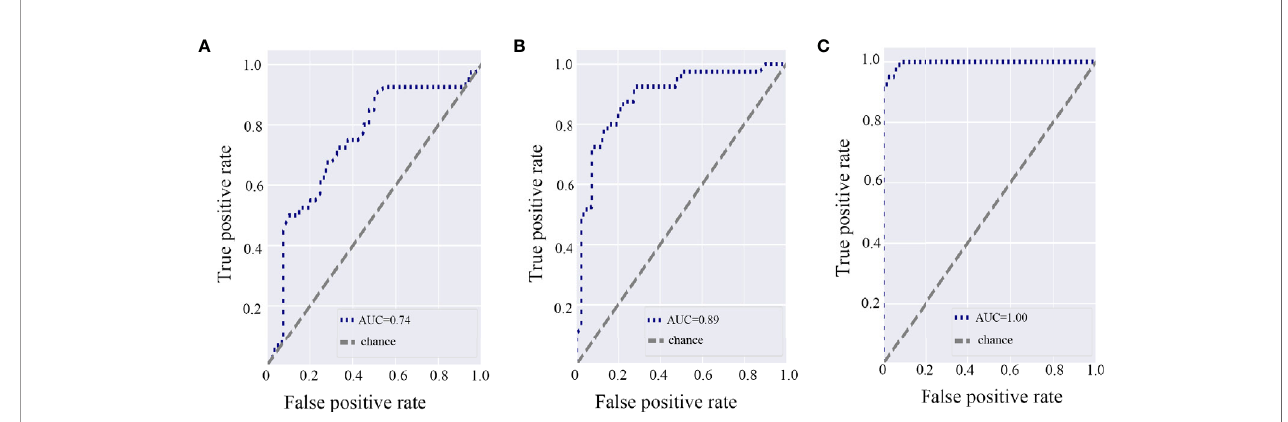
FIGURE 5 | Gut and oral microbiota differentiate rheumatic heart disease patients from control subjects. (A) Receiver operating characteristic (ROC) curve according to random forest model for fecal microbiota. A greater area under the ROC curve (AUC) indicates better performance. (B) ROC curve according to random forest model for subgingival plaque microbiota. (C) ROC curve according to random forest model for